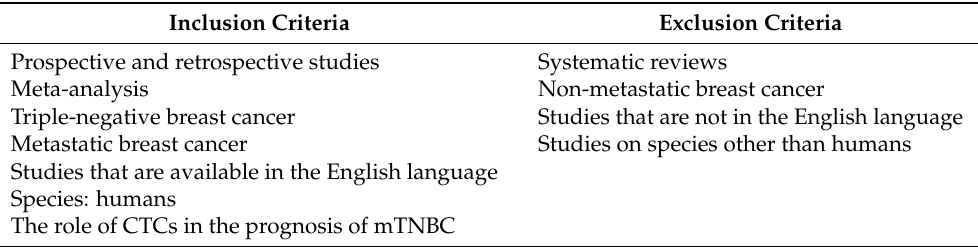
Table 1. Inclusion and exclusion criteria for the analyzed studies.